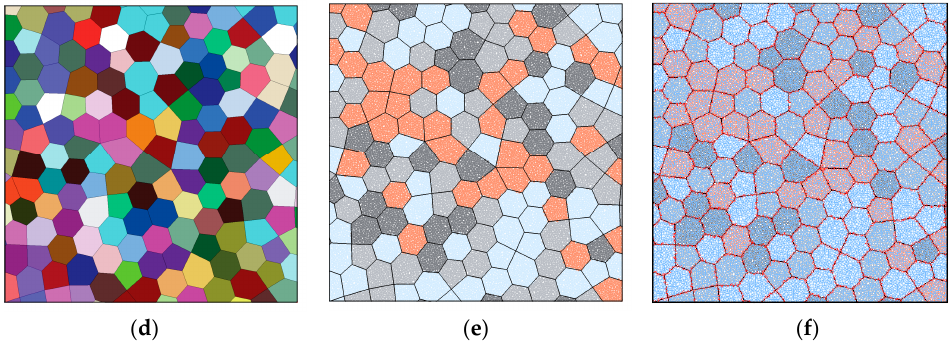
Figure 7. Steps in the generation of a grain-based model based on the initial particle seeds in PFC5.0 ( a – f ). ( a ) Initial particle packing; ( b ) Development of polygons; ( c ) Polygonal grain structure; ( d ) Different grain types; ( e ) Particles in mineral grians bonded by parallel bond; ( f ) Grain boundaries mimiced by smooth joint model (red).